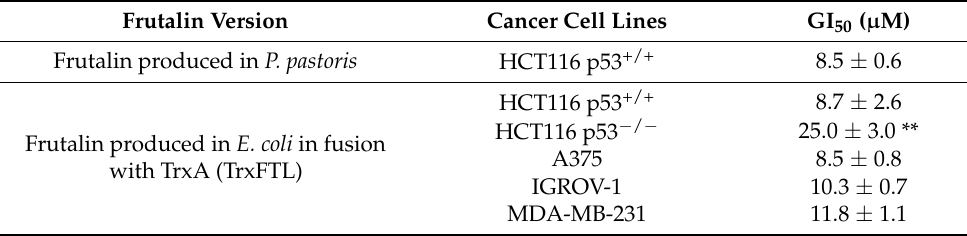
Figure 6. Dose-response curves of the growth inhibitory effect of TrxFTL on human cancer cell lines, determined by the SRB assay, after 48 h treatment. Data are shown as mean ± SEM ( n = 4–6 independent experiments). Table 2. Effect of frutalin produced in E. coli in fusion with TrxA (TrxFTL) on the growth of different human cancer cell lines and effect of frutalin produced in P. pastoris on the growth of HCT116 p53 +/+ cell line (control).